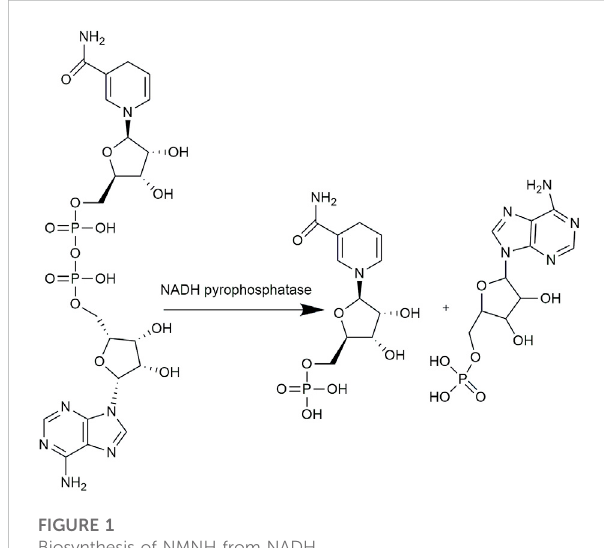
FIGURE 1 Biosynthesis of NMNH from